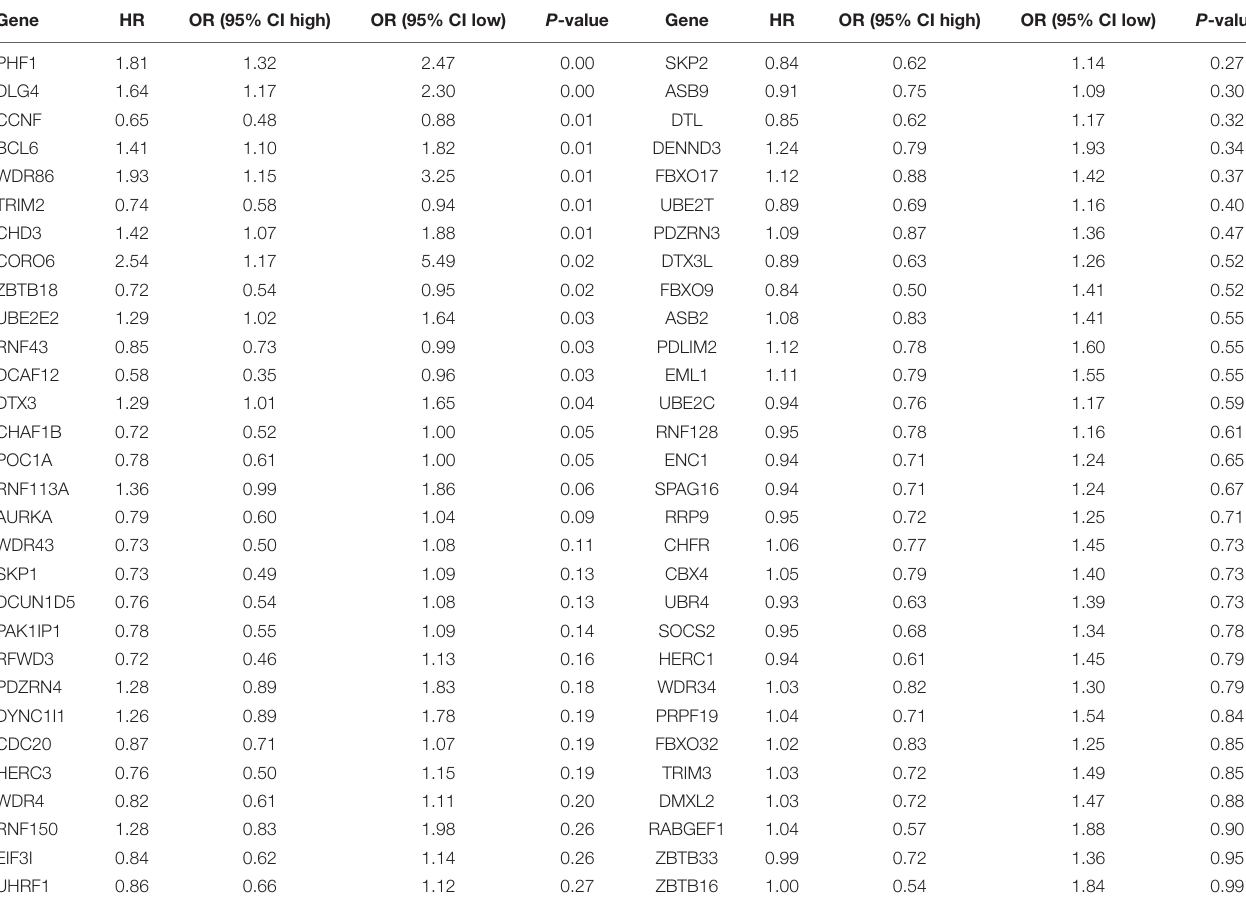
TABLE 2 | The results of univariate Cox analysis based on 60 differentially expressed UPS-associated genes. Gene HR OR (95% CI high) OR (95% CI low) P -value Gene HR OR (95% CI high) OR (95% CI low) P